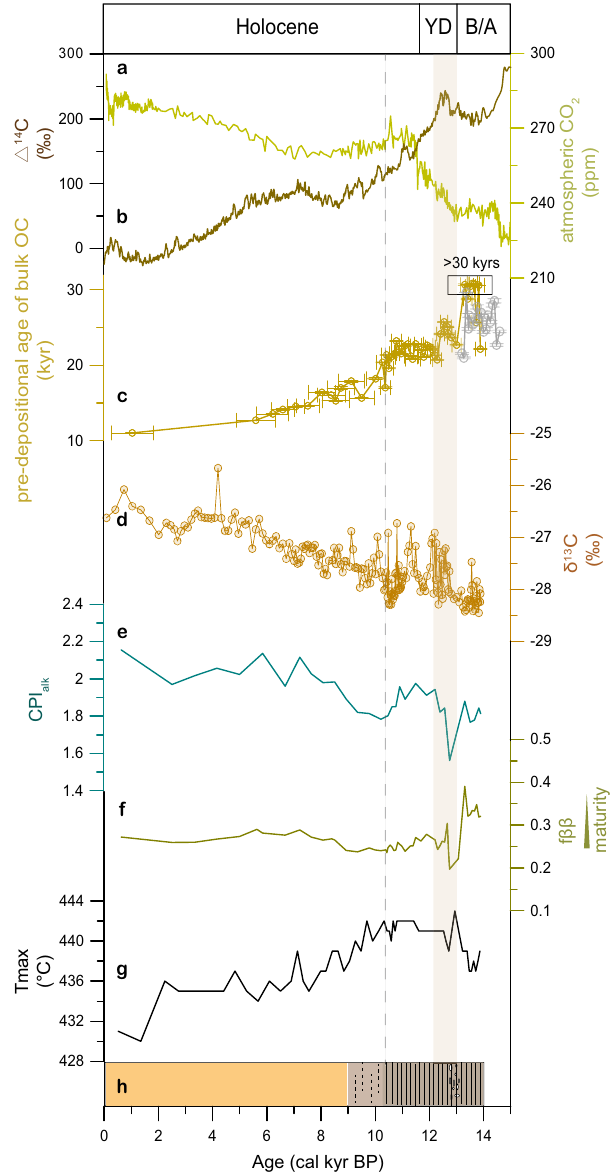
Fig. 2 | Characteristics and thermal maturity ofsedimentary organic matter in the Canadian Beaufort Sea. a atmospheric CO 2 concentrations 70 ; b radiocarbon content reconstructed in IntCal13 67 ; c pre-depositional age of bulk OC, brownish yellow for core ARA04C/37 and gray for core JPC15. Error bars represent standard deviation; d δ 13 C org valuesincoreARA04C/37 28 ; e – g thermalmaturityproxiesCPI alk (carbon preference index of high molecular weight n-alkanes), f ββ (fractional abundance of “ biological ” homohopane to its diagenetic isomers), and T max (temperature at which pyrolysis yields the maximum of hydrocarbons) of core ARA04C/37; h lithology and sedimentary texture (according to Supplementary Fig.2),darkbrownsectionindicates fi nelylaminatedsedimentsandorangesection indicate bioturbated silty clay. The light brownish section with dashed lines represents the transition characterized by weakly laminated sediments. Abbrevia- tions in the fi gure are de fi ned as YD Younger Dryas, B/A